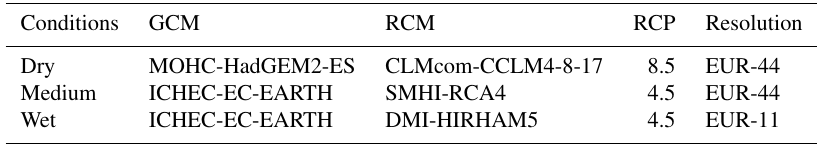
Table 2. Characteristics of the three climate model chains used in the C_F_scen runs: global climate model (GCM), regional climate model (RCM), relative concentration pathway (RCP), and spatial resolution of the climate model.